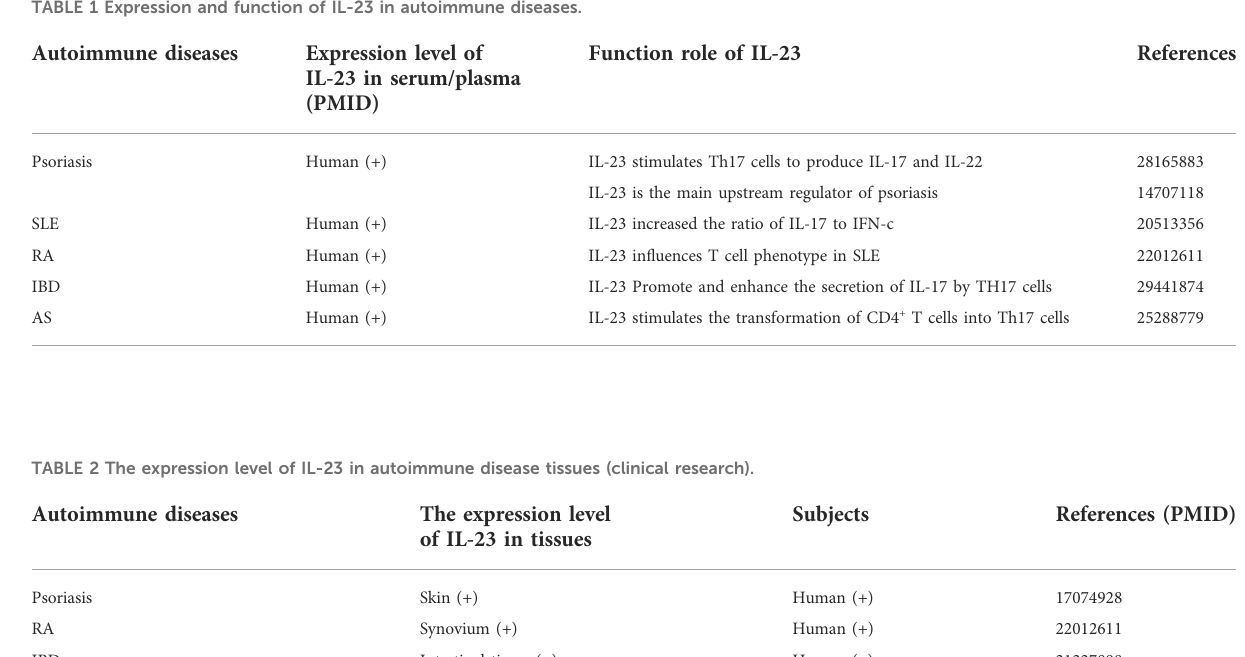
TABLE 1 Expression and function of IL-23 in autoimmune diseases.